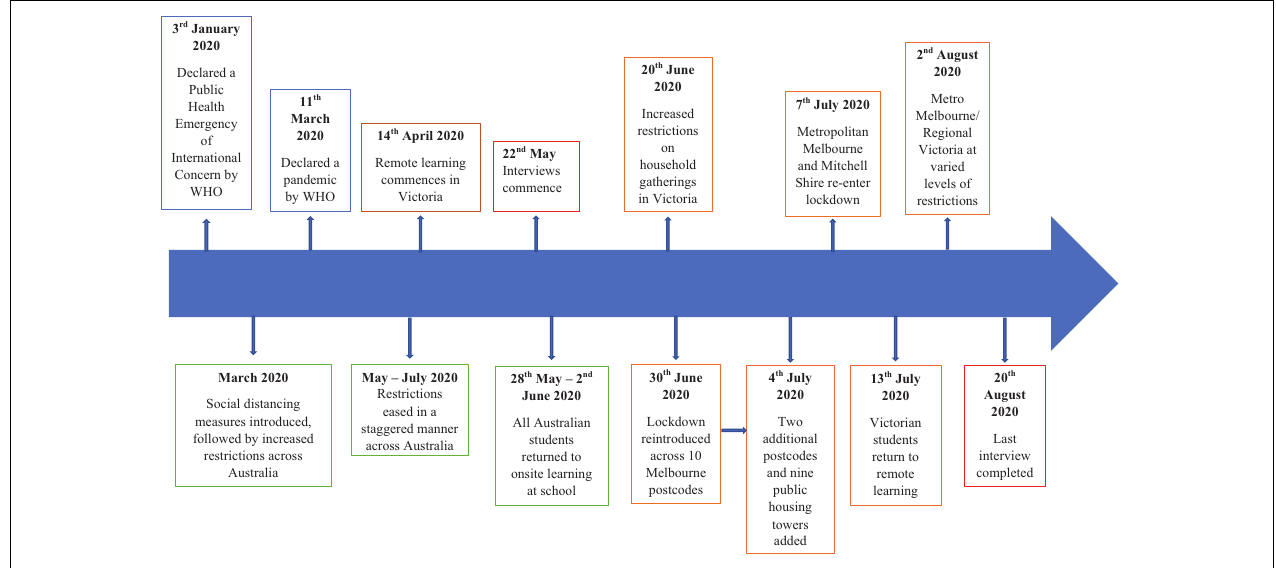
FIGURE 1 | Key milestones in Australia’s response to COVID-19 and Victorian specific restrictions.